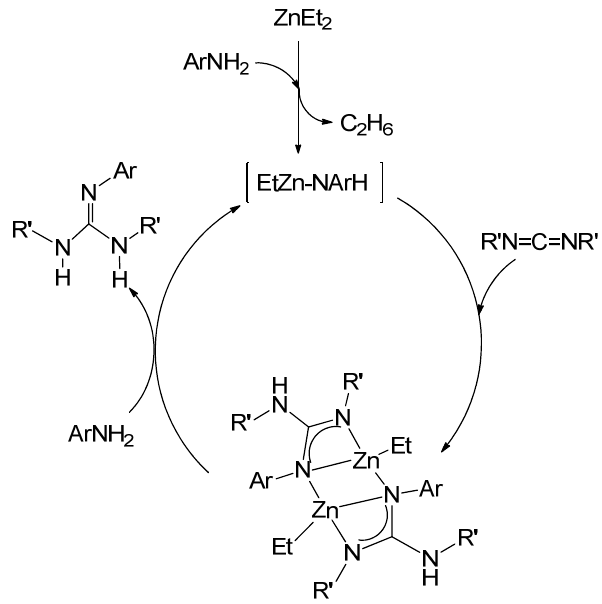
Figure 15. Catalytic guanylation of amines using ZnEt 2 as a precatalyst.